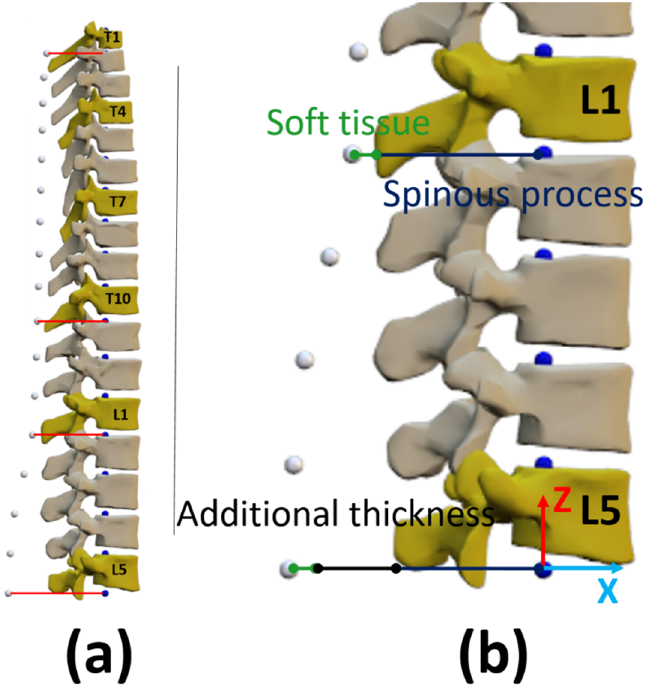
Figure 4. ( a ) Multibody model of the human thoracolumbar spine; ( b ) Longitudinal displacement. Blue dots: origins of local reference systems of vertebrae. White dots: estimated skin surface.